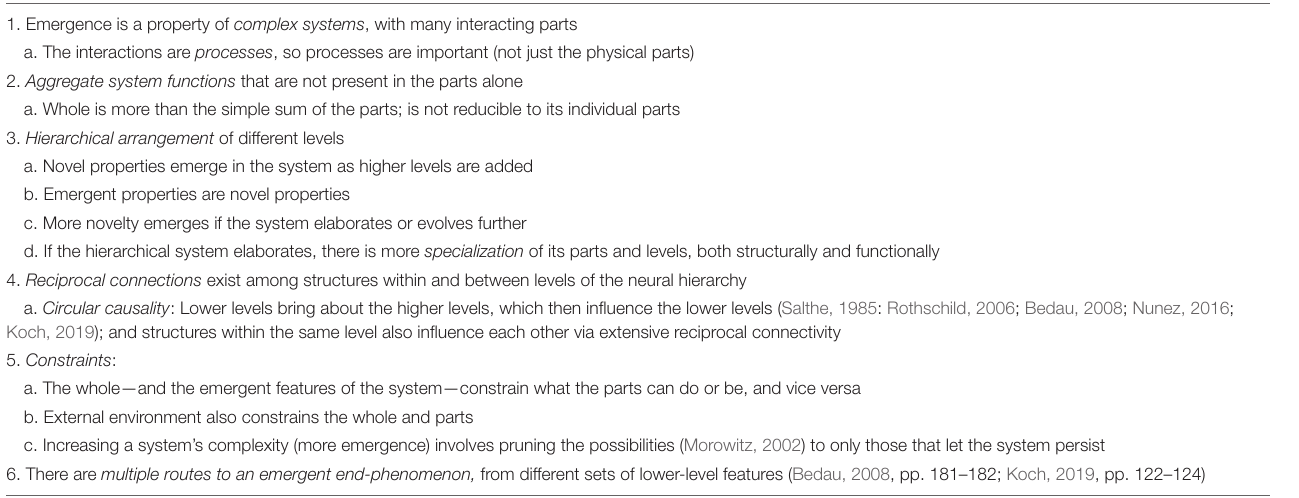
TABLE 1 | Major features of emergence in